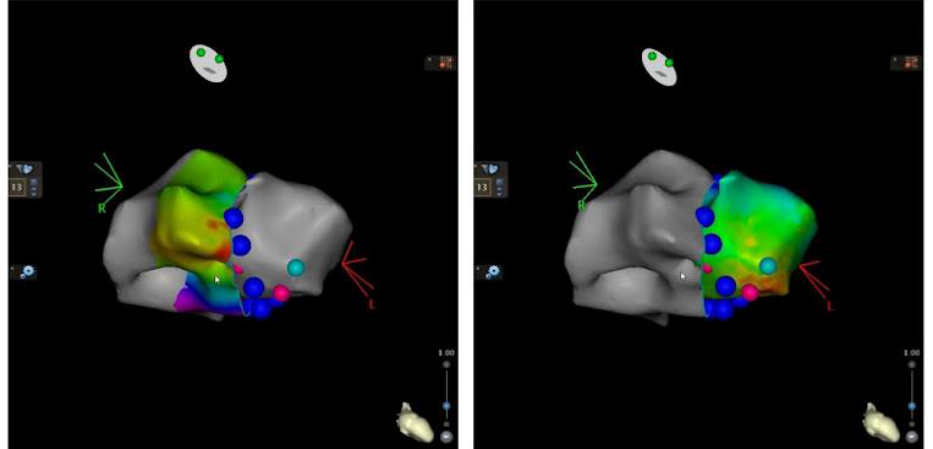
Figure 3. Limited 3D atrial mapping during orthodromic AVRT ( left ) and limited 3D ventricular activation mapping during antidromic AVRT ( right ); pink dots: earliest atrial and ventricular signals, respectively; dark-blue dots: tricuspid annulus; light blue dots: mark the limit from which ventricular electrograms no longer precede the surface QRS.